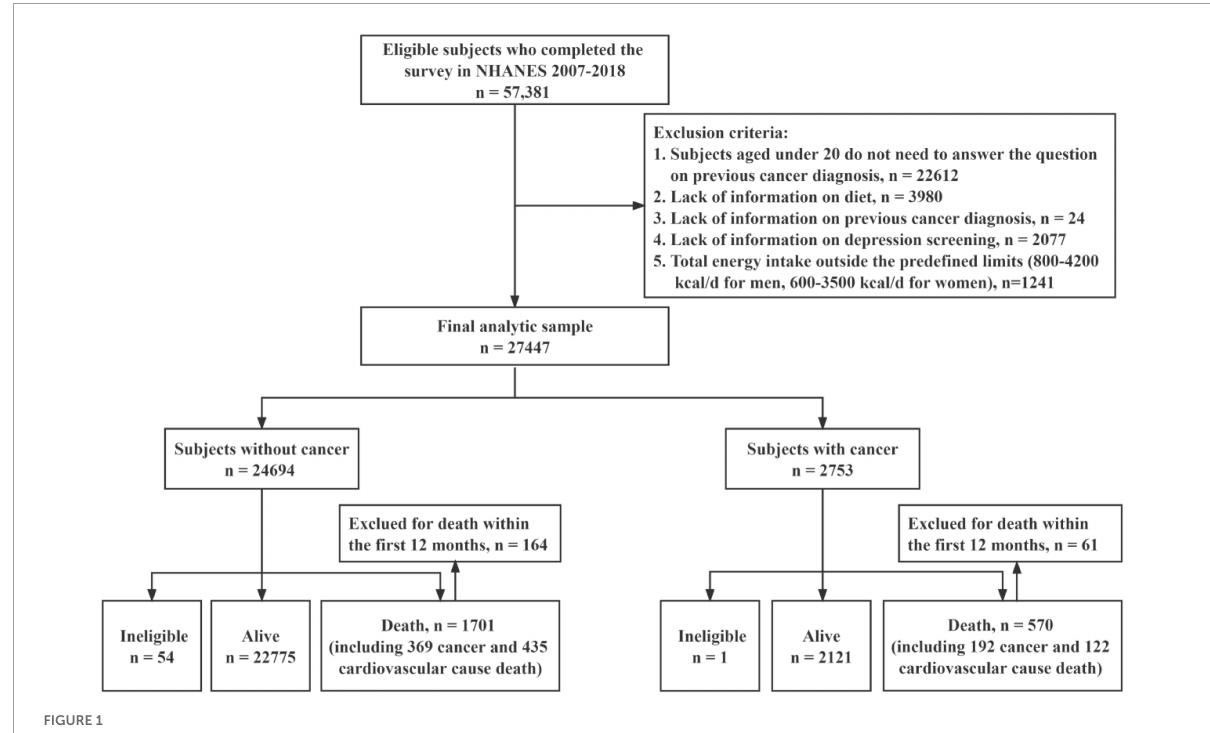
FIGURE1 Flow chart of participant